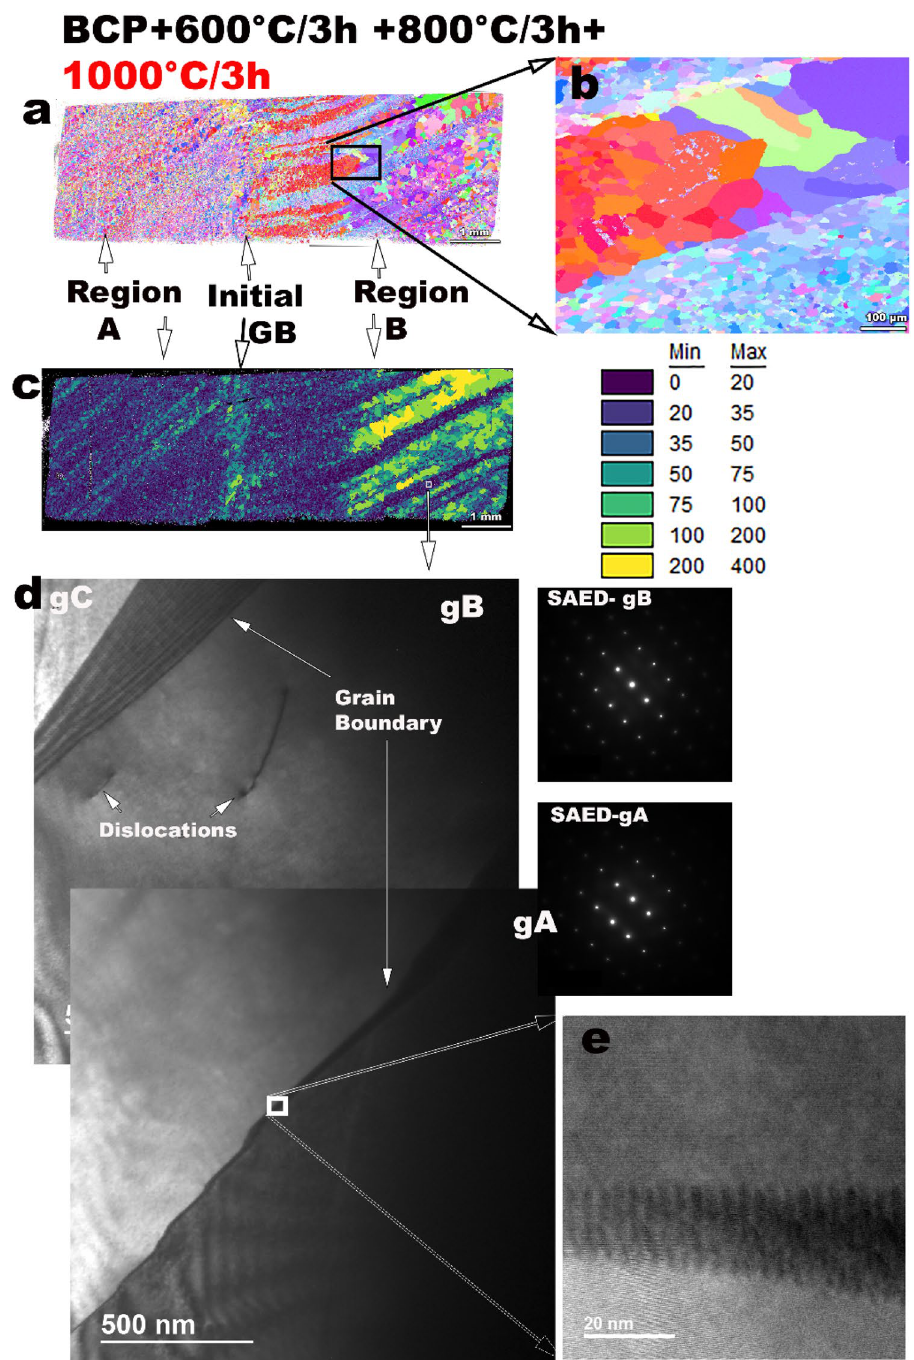
Figure 3. Microstructure development after 1000 °C/3 h heat treatments as indicated by IPF maps as well as TEM microscopy: ( a ) IPF map of the entire sample indicates growth textures differ from deformation textures, and formation of mostly a 30–50 µm fine grain (FG) microstructure in Region A, and ( b ) duplex large grain (LG)-fine grain (FG) microstructure characteristic of Region B, ( c ) grain size distribution map from ( a ) with the color code for grain size in μm, ( d ) bright field (BF) STEM with corresponding selected area electraon diffracton (SAED) patterns of the fine grains from Region B at z = [110] zone axis, indicating very few dislocations and no dislocation networks, as well as clean grains as observed in a representative high magnification image ( e ). The IPF’s were generated using the TSL OIM Analysis (Version 7.0), link: https ://www.edax.com/produ cts/ebsd/ oim-analy